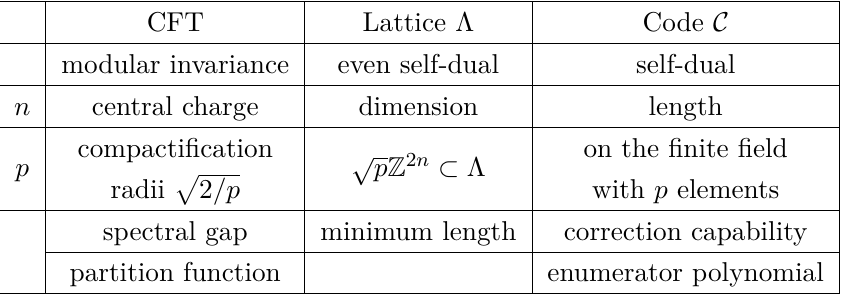
Table 1. The relation between CFTs, lattices and